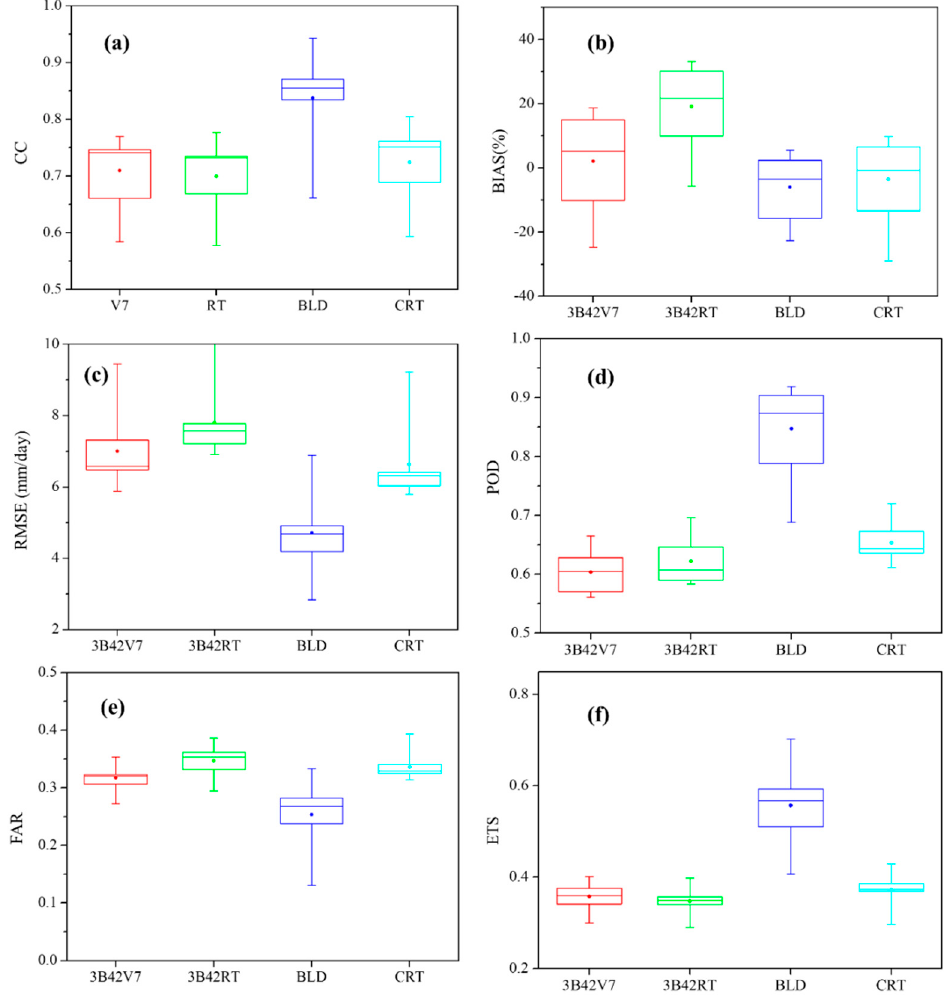
Figure 4. Box plots of grid based metrics for different precipitation products at daily timescale from 2006–2013: ( a – f ) represents CC, BIAS, RMSE, POD, FAR, and ETS, respectively.